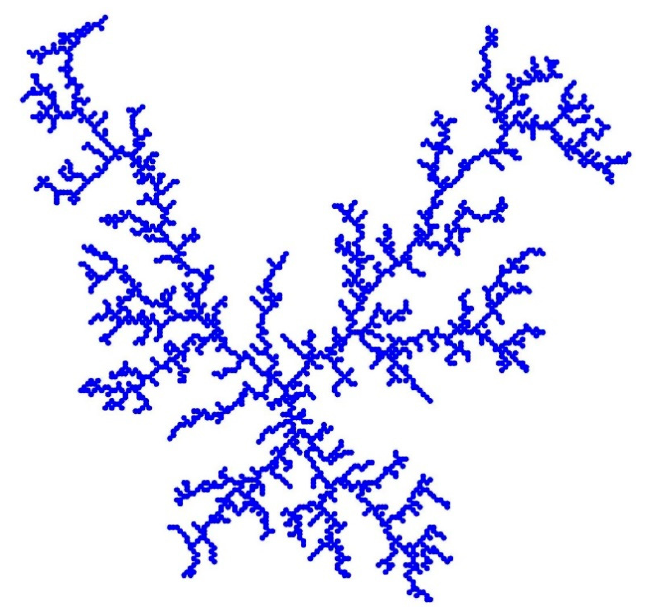
Figure 5. Dendritic pattern simulated by DLA (250 × 250 lattice, 30,000 particles).